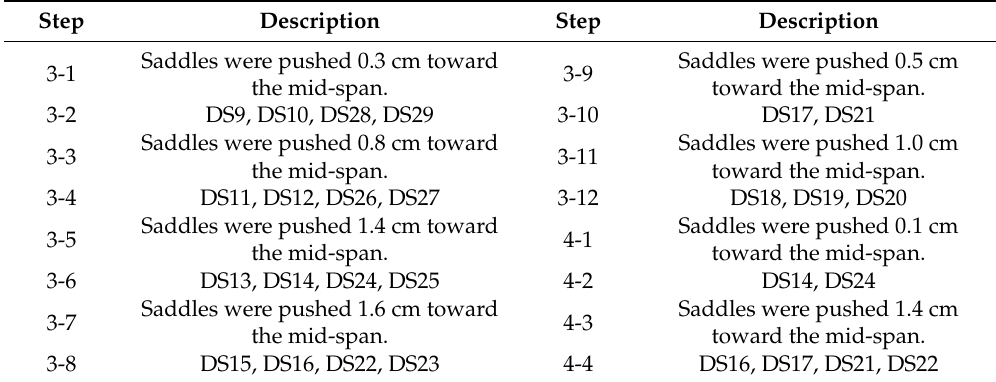
Table 6. Specific steps of tensioning rounds 3 and 4.